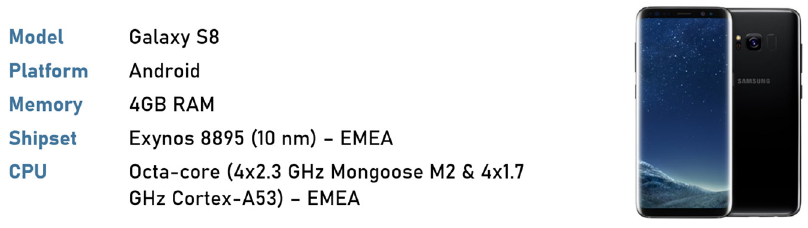
Figure 15. Samsung Galaxy S8 Specification .